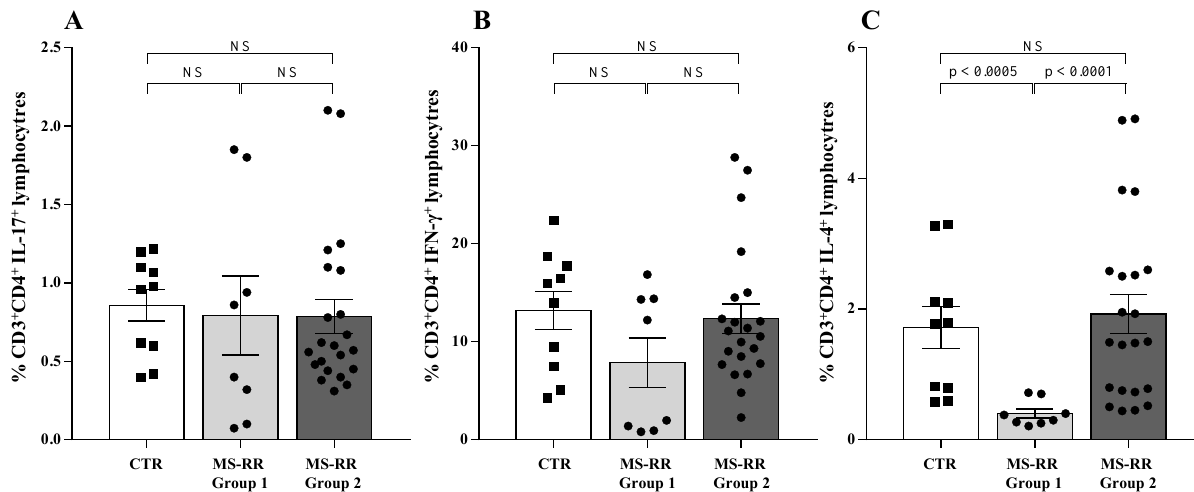
Figure 8. Low SOD-1 intracellular content in T cells correlated with reduced IL-4 production by CD4 + T lymphocytes in MS-RR individuals. To analyze the cytokine profile, PBMC were cultured overnight in the presence of PMA and ionomycin. White column with black squares represents the healthy controls; light grey column with black dots represents the MS-RR Group 1 subjects; dark grey column with black dots indicates the MS-RR Group 2 individuals. ( A ) IL-17 production by CD4 + T lymphocytes. ( B ) IFN- γ production by CD4 + T lymphocytes. ( C ) IL-4 production by CD4 + T lymphocytes. Statistical evaluation of data was performed by means of the Mann–Whitney